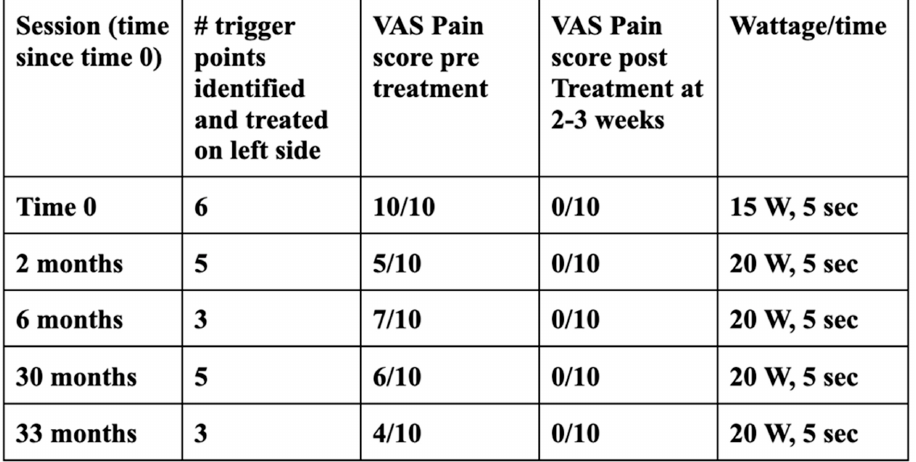
Figure 4. The patient received a total of five treatments. The important points from each visit are outlined